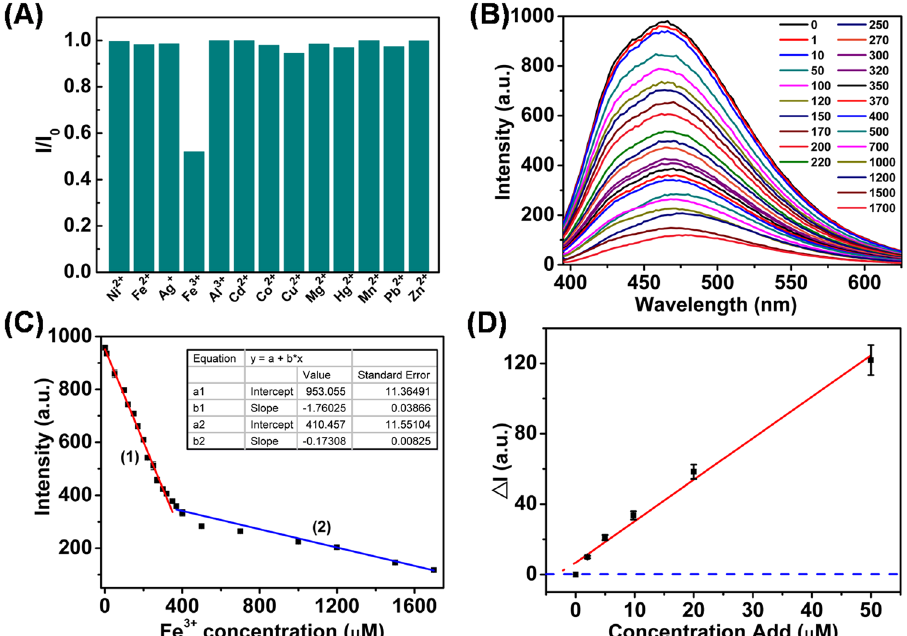
Figure 6. ( A ) Remained percentage of the CNDs PL intensity upon addition of different metal ions all at 250 µ M in acidic conditions (pH = 6.0). ( B ) PL intensity of the CNDs in the presence of Fe 3 + ions at different concentrations from 0 to 1700 µ M. ( C ) Plot of PL intensity of CNDs against the Fe 3 + concentrations. ( D ) Detection of Fe 3 + ion in tap water using a standard addition method. Excitation at 370 nm was applied. Error bars indicate standard deviations of the means (n = 3).